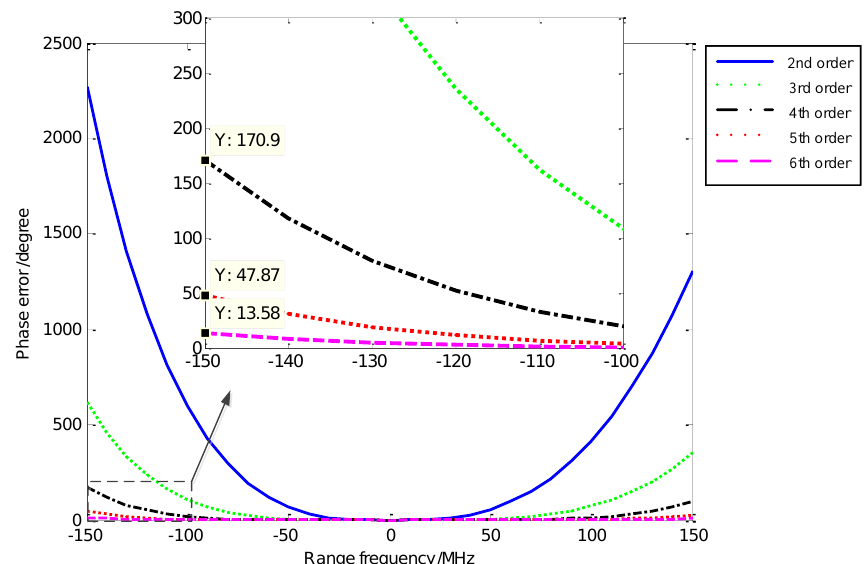
Figure 3. Range-dependent coupling phase errors of 2nd to 6th order Taylor series approximation. The point target at the slant range 12 km with a center frequency of 600 MHz, a bandwidth of 300 MHz, a beamwidth of 29 ◦ and the reference slant range of 10 km.